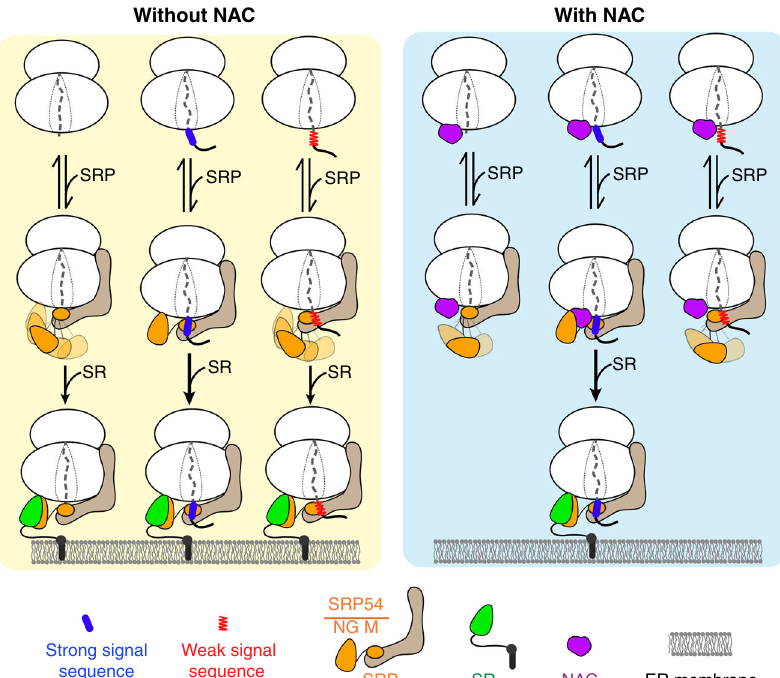
Fig. 8 Model for how NAC allosterically regulates SRP to ensure the speci fi city of cotranslational protein targeting. Left panel: Without NAC, the ribosome dominates the interactions of SRP, and even RNCs with a weak signal sequence (red zigzag line) or with a short nascent chain can induce SRP to dynamically sample the proximal conformation that rapidly associates with SR at the ER. Right panel: NAC (purple) co-binds with SRP to a variety of RNCs and selectively drives SRPs into inactive conformations on RNCs with a weak signal sequence or a short nascent chain, thus inhibiting the ER localization of ribosomes without an exposed and functional signal